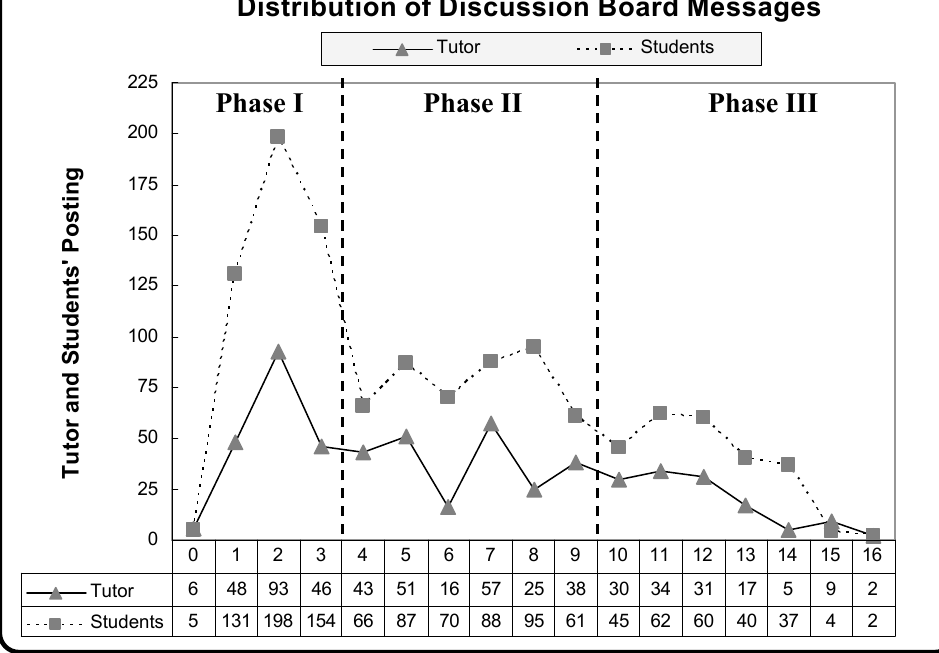
Figure 1. Overall distribution of discussion board postings from week 0 to week